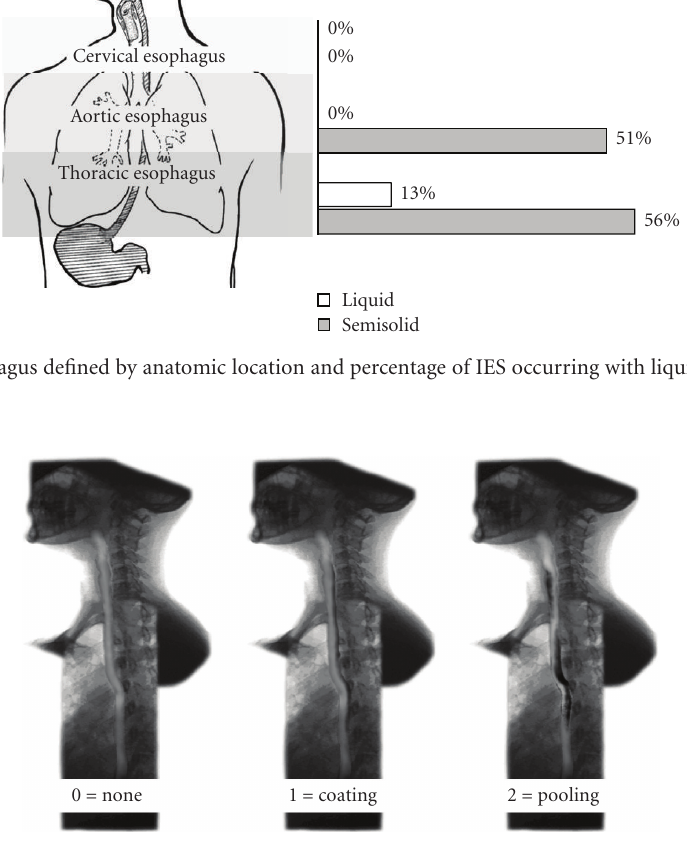
Figure 2: Grading of stasis of barium: the absence of IES was graded a 0, a coating of barium or a minimal amount of barium retention was scored as 1, and stasis with retained barium that completely filled the lumen of the esophagus was graded as